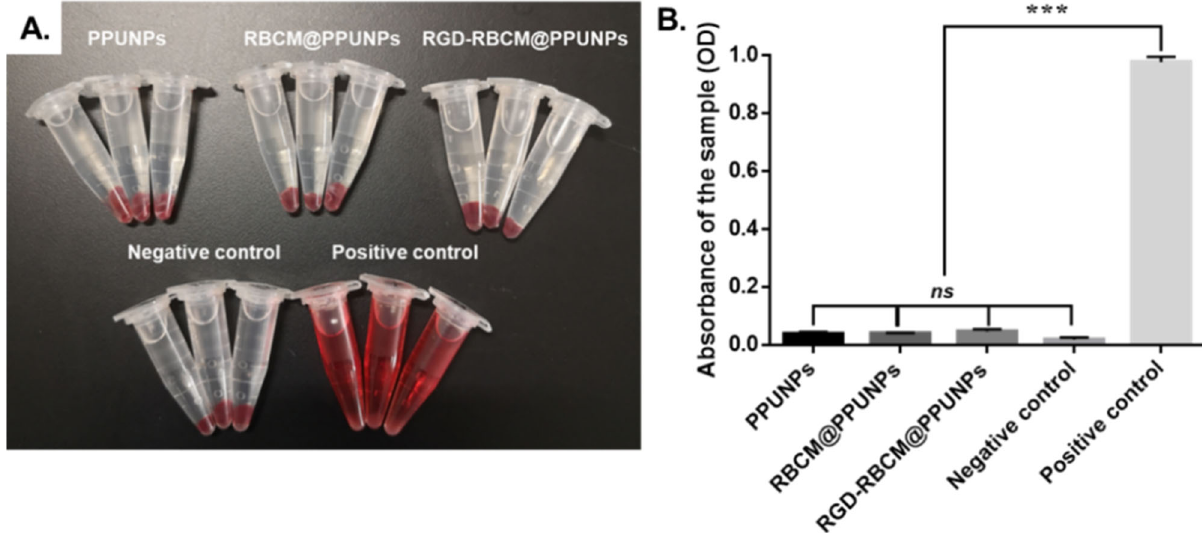
Fig. 6 A The graph after centrifugation in the hemolysis experiment, B The absorbance after the hemolysis experiment ( n = 3). ***p < 0.001, ns: no signi fi cant